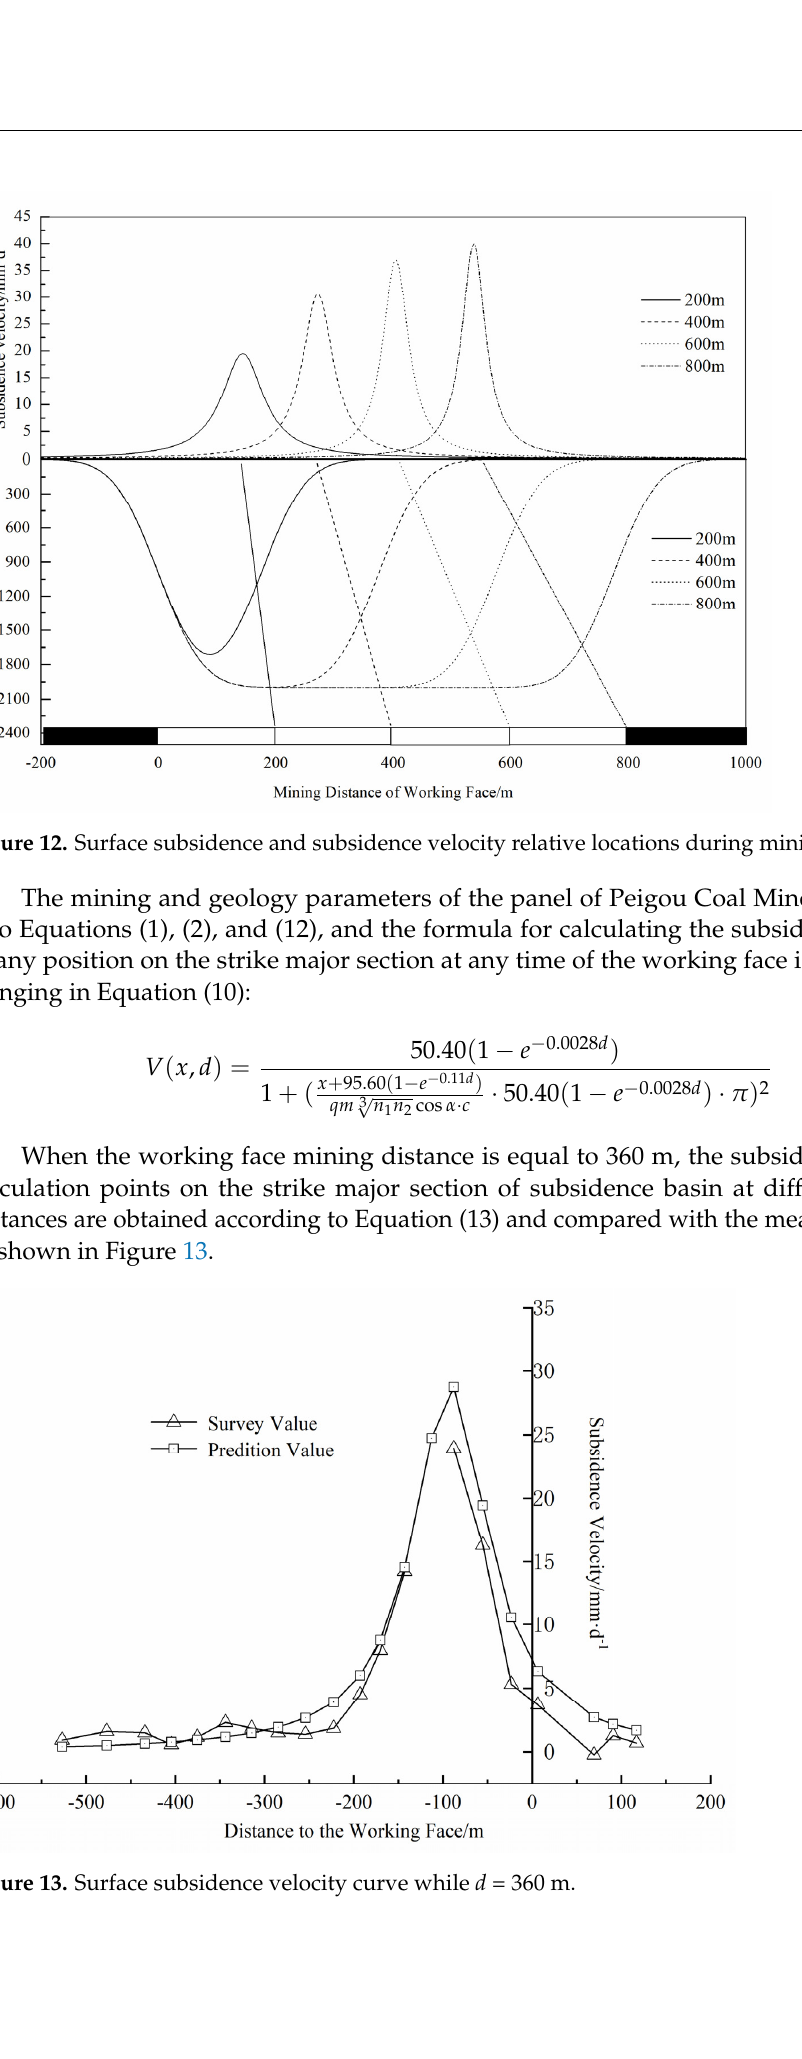
Figure 13. Surface subsidence velocity curve while d = 360 m.